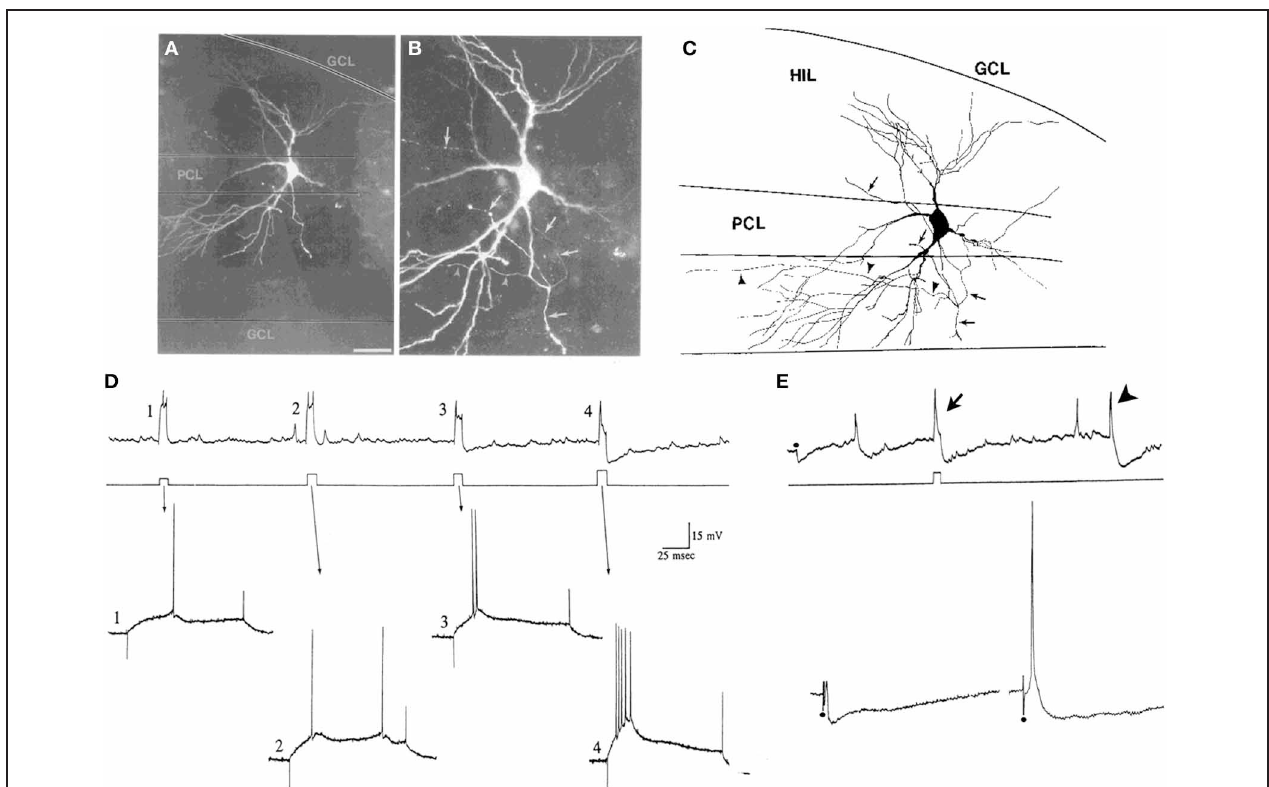
FIGURE 5 | Characteristics of CA3c “pyramidal cells” and mossy cells. (A,B) Pyramidal cells of CA3c often have morphology that is not pyramidal-like in that the cell body and proximal dendrites are not pyramidal. They are not interneurons because of their dense spines and physiology. The example shown is from a neuron that was physiologically-identified as a pyramidal cell because of its intrinsic burst firing (D) . The merged images through multiple focal planes are shown. Calibration [located in (A) ] = 100 μ m for (A) and 20 μ m for (B) . (C) A drawing of the cell in (A,B) is shown. Arrowheads indicate the part of the axon that terminated in area CA3. The arrows point to the part of the axon that gave rise to collaterals in the hilus. GCL, granule cell layer; HIL, hilus; PCL, pyramidal cell layer of CA3c. (D,E) Physiological discrimination of CA3c neurons from hilar mossy cells. (D) A continuous recording from a neuron in CA3c (top) that exhibited firing behavior of a pyramidal cell rather than a mossy cell. During the record, a series of increasing currents are triggered (middle) to elicit firing and the firing behavior is expanded below (arrows). Weak currents (#1–3) did not elicit